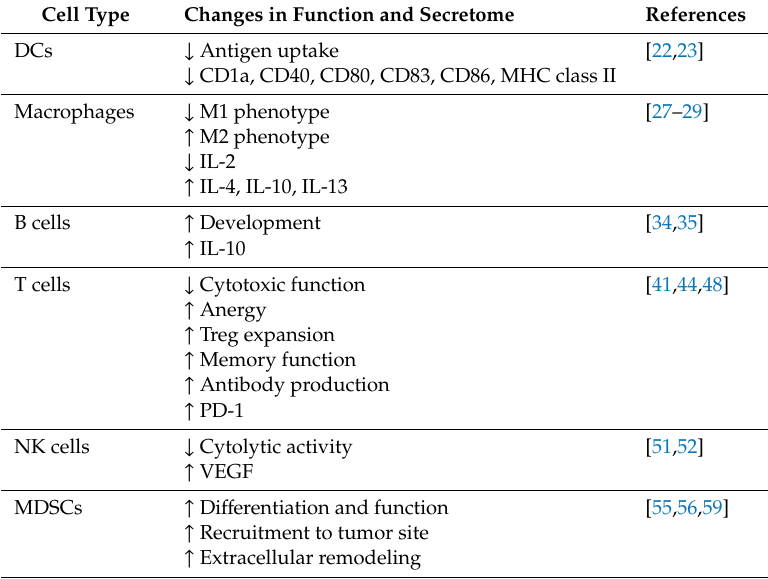
Table 1. Changes in immune cell phenotypes and secretome during